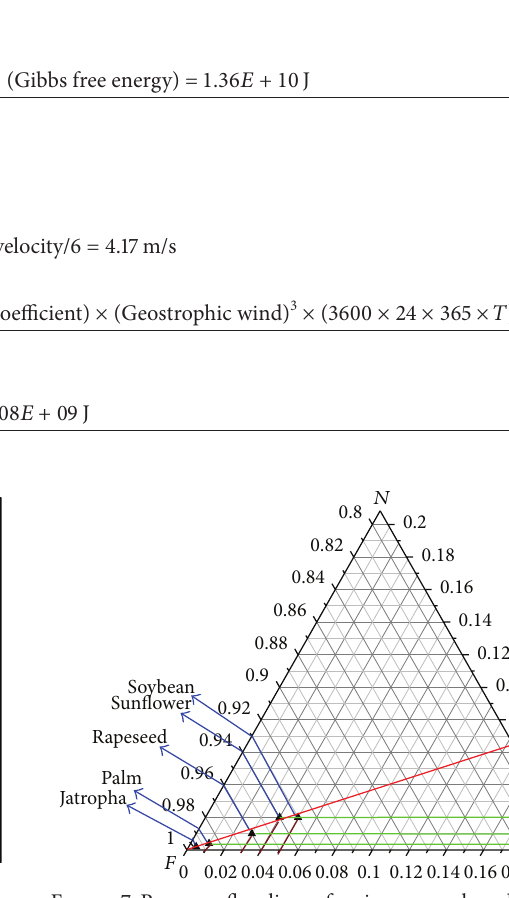
Figure 7: Resource flow lines of various crops-based biodiesel in the emergetic ternary